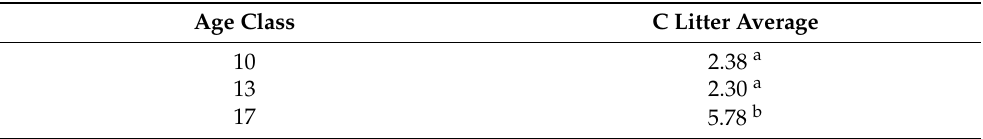
Table 9. Honest Tukey’s significant difference test results for the average amounts of C stored in the litter under D. polyphylla stands with three age classes.